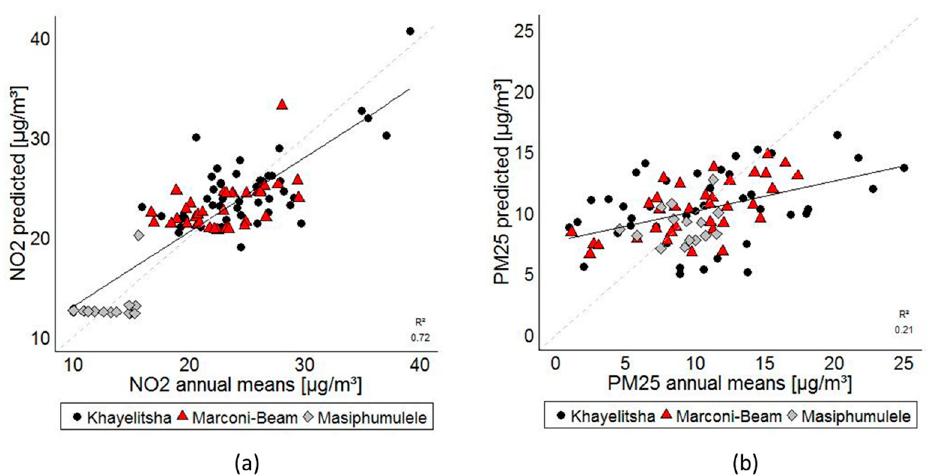
Figure 3. ( a ) Validation of NO 2 predicted values against NO 2 annual means. Scatter plot based on the results of leave-one-out-cross-validation (LOOCV), by study area; ( b ) validation of PM 2.5 predicted values against PM 2.5 annual means. Scatter plot based on the results of LOOCV, by study area. The 1:1 relationship between measured and predicted values is presented as a dotted line.